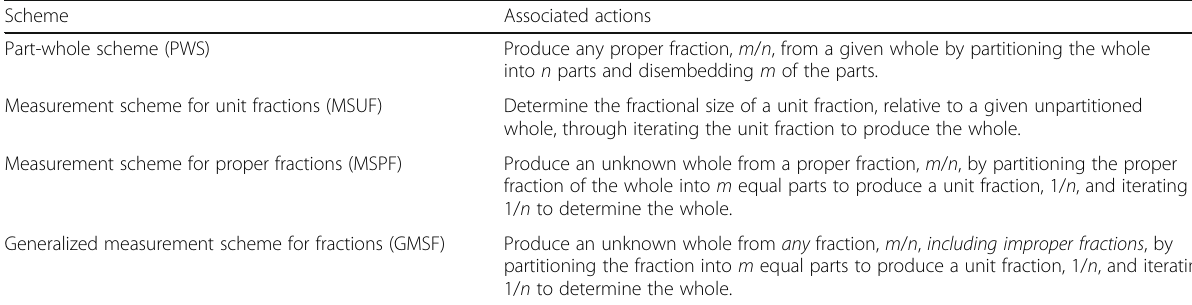
Table 3 Progression of four fraction schemes Scheme Part-whole scheme (PWS) Measurement scheme for unit fractions